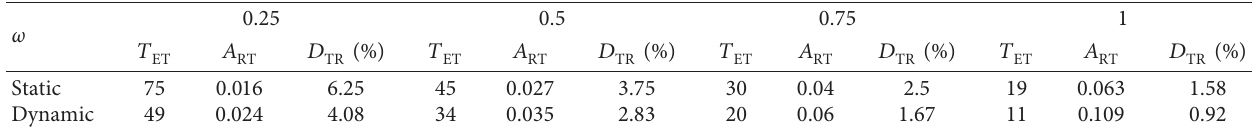
Table 1: For different values of ω and fixed t � 1.2, h � 0.001, times of event-triggering T rate D under static and dynamic triggering conditions (53) and TR